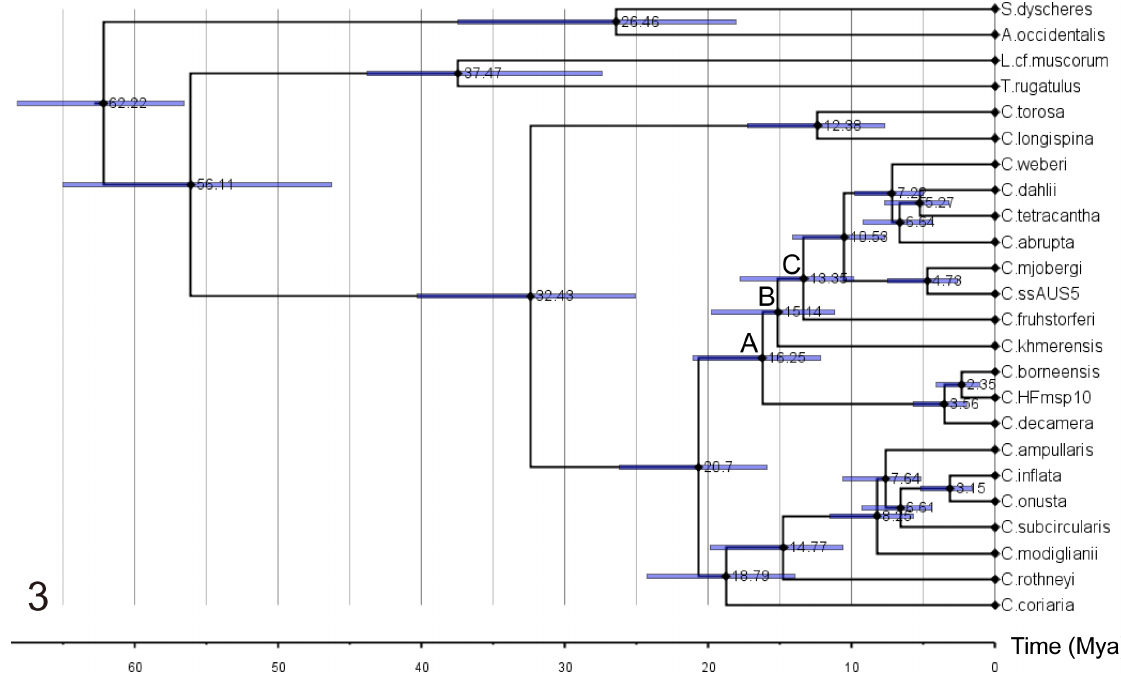
Fig. 3. Posterior estimates of divergence time of 24 taxa on the phylogenetic tree. Blue bars depict the 95% highest posterior density (HPD). Estimations were performed with MCMCTree using the independent rate